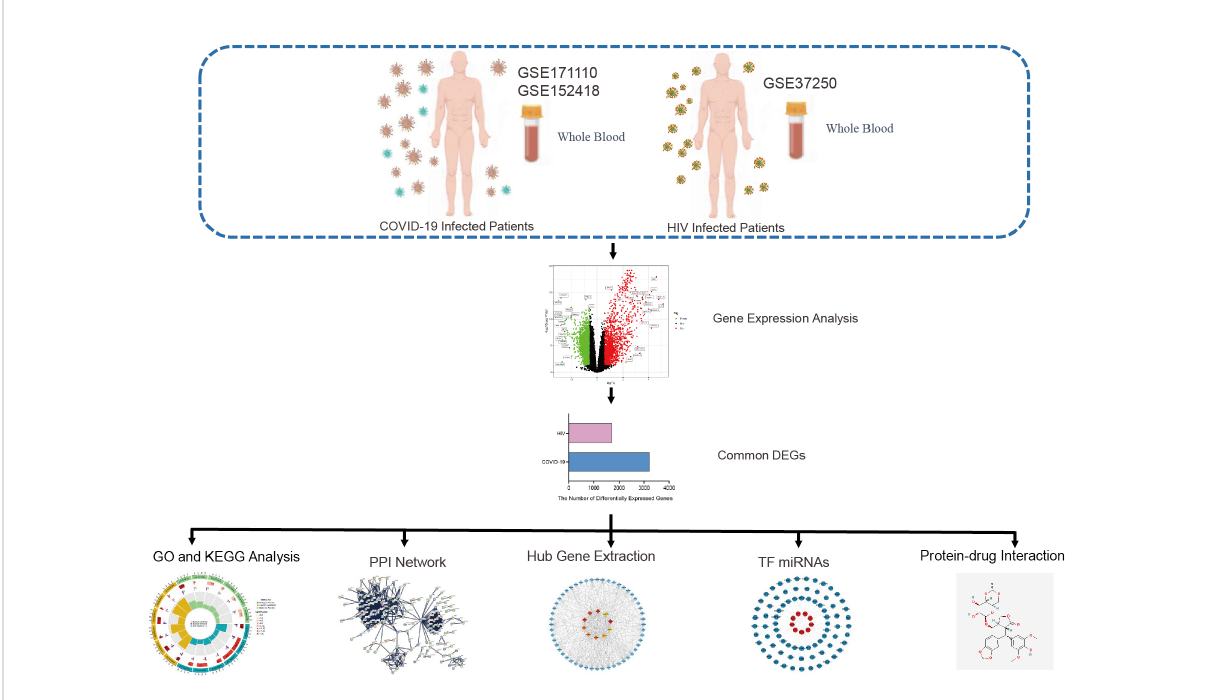
FIGURE 1 The entire work fl ow diagram of our